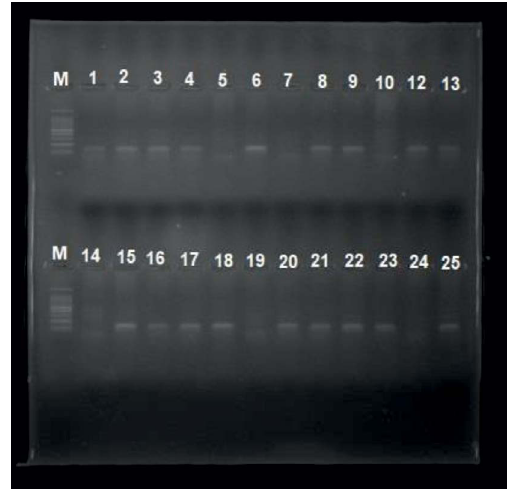
Fig. 1 . Gel electrophoresis for PCR product of P53 gene polymorphism (Arginine) M ladder, lane 1, 2, 3, 4, 6, 8, 9, 12,13,15, 16, 17, 18, 20, 21, 22, 23, 25 positive results